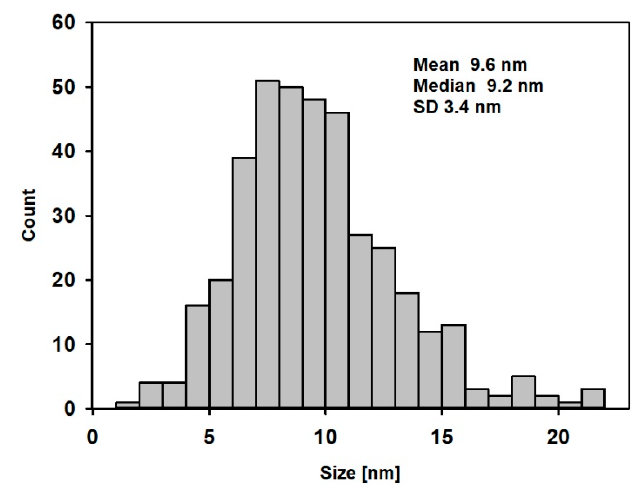
Figure 3. TEM particle size distribution of AgNPs.